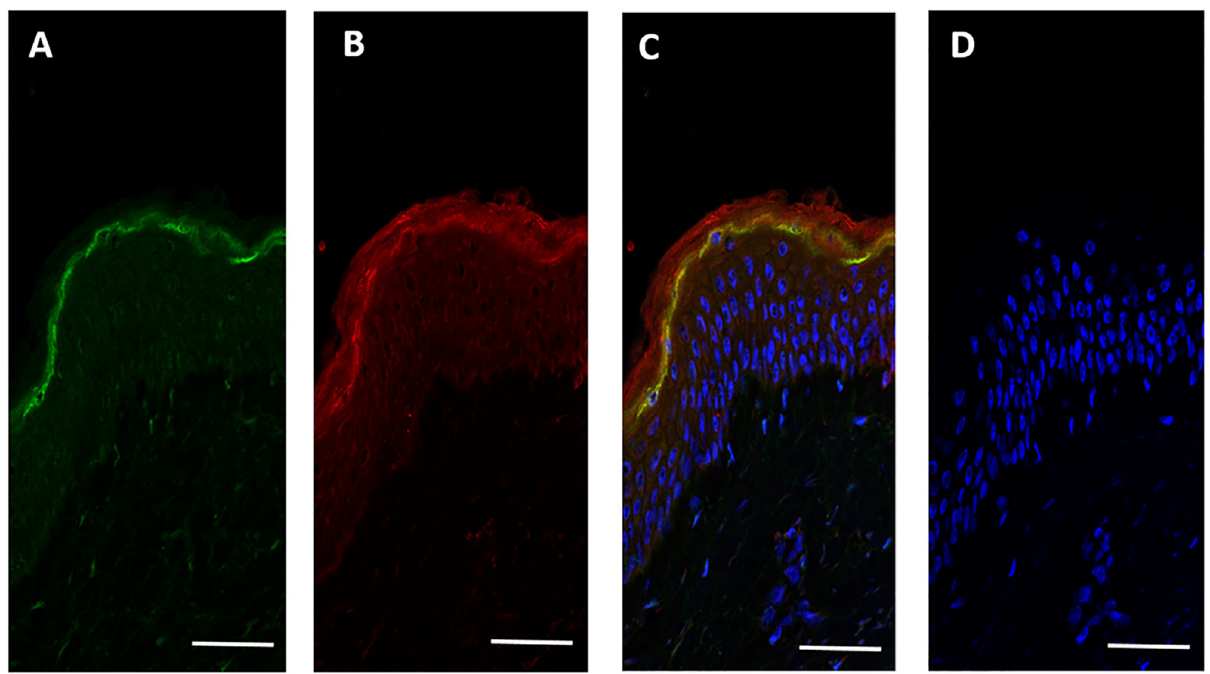
Fig 3. SASPase 28 and FLG2Nter co-expressed in the stratum granulosum of human epidermis. Confocal immunohistochemical analysis of the expression of SASPase 28 and the FLG2Nter on frozen sections from human skin A) SASPase 28 (in green) B) FLG2Nter (aa 2–213) (in red) C) Overlay showing co-expression of SASPase 28 and FLG2Nter in the SG of human epidermis (in yellow) D) control without primary antibodies. Nuclei stained with Hoescht dye (blue) (c & d). Scale bar = 25 μ M.